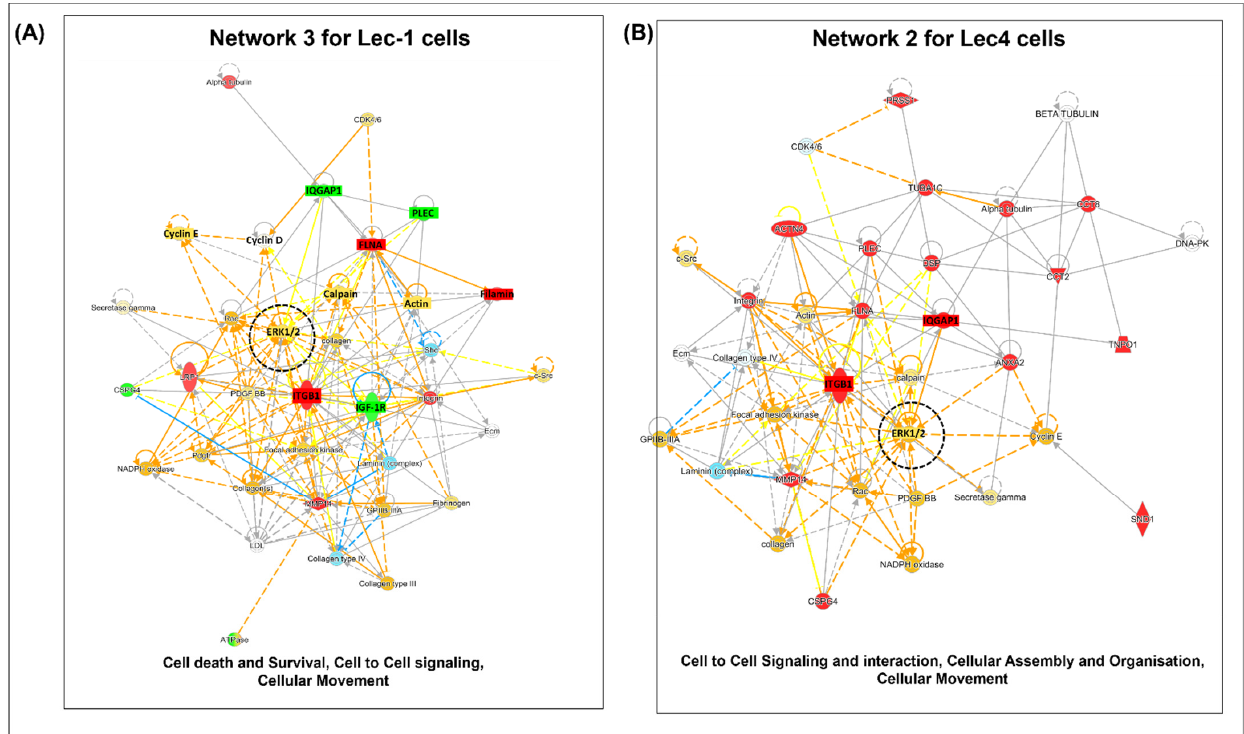
Figure 5. Top networks in Lec1 and Lec4 cells derived from Ingenuity Pathway Analysis. Upregu- lated genes are labeled in red, while downregulated genes are labeled in green. Ellipses represent transcription regulators, rhombuses represent enzymes, trapezoids represent transporters, double circles represent a complex/group, and circles represent others. ( A ) In Lec1 cells, network 3 was associated with ERK1/2. Focal adhesion kinase, Ecm, fibrinogen, collagen, actin, filamin, and Plec integrins regulate ERK molecules. ( B ) In Lec4 cells, network 2 was associated with cell-to-cell signaling and interaction, cellular assembly and organization, and cellular movement. The central molecules were ERK and integrin, ITGB1, ERK, tubulin, IQGAP1, laminin, collagen, FLNA, and